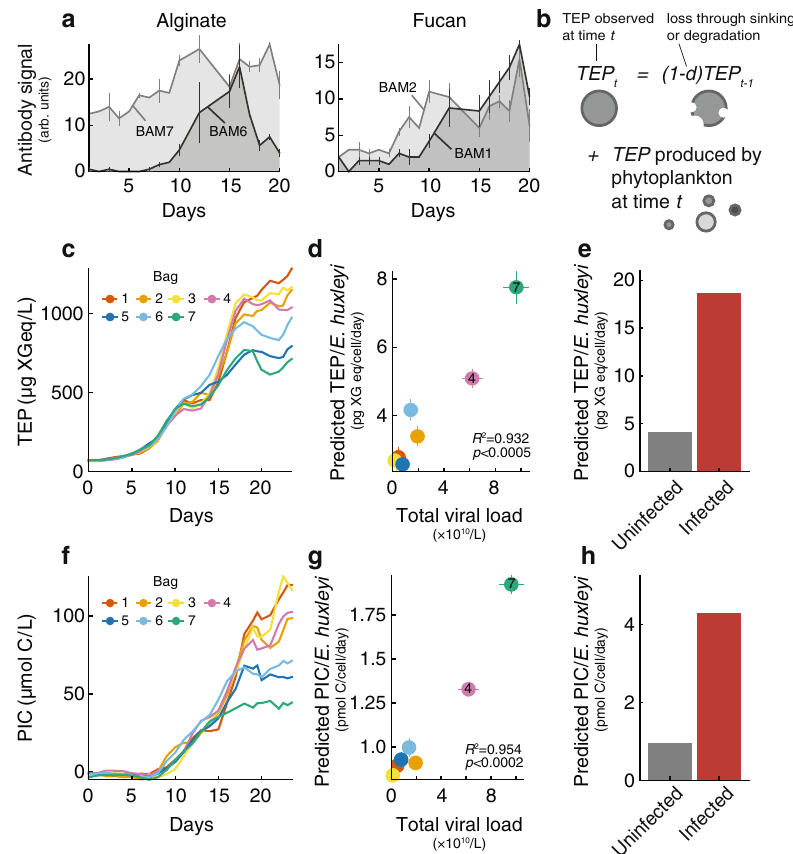
Fig. 4 | Viral infection promotes release of PIC and TEP production from a coccolithophore bloom. a Alginate and fucan abundance in particulate organic matter (POM) over time, based on mixed water from bags 1 – 4, measured by car- bohydrate microarray analysis. BAM1, 2, 6 and 7 correspond to glycan-speci fi c monoclonal antibodies, used to measure the relative abundance of their recog- nizedpolysaccharideepitopesinPOMwaterextracts.Linescorrespondtomeanof between n =2 and n =5 fi lters used per day, error bars represent standard devia- tions across samples. b Scheme of TEP modeling, as a function of phytoplankton concentrations and degradation rate which enables prediction of the E. huxleyi contributiontotheTEPpool. c TEPconcentrationmeasuredbyAlcianbluestaining